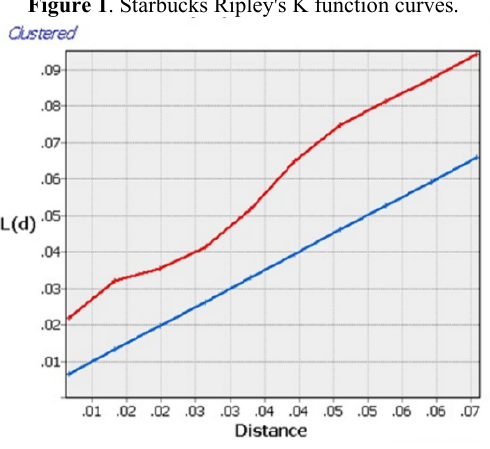
Figure 1 . Starbucks Ripley's K function curves.